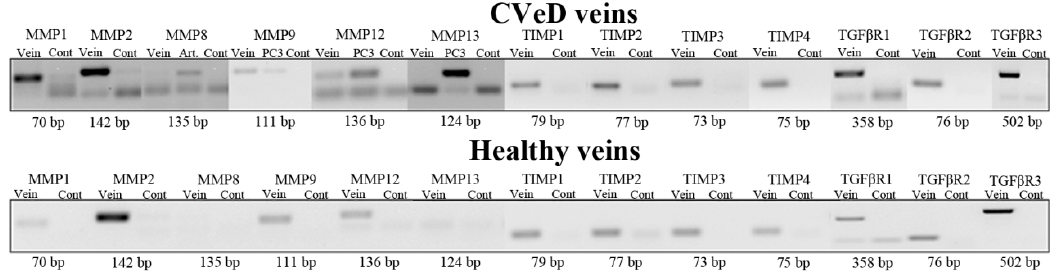
Figure 1. PCR analysis of several matrix metalloproteinases (MMPs), tissue inhibitors of metalloproteinases (TIMPs), and transforming growth factor- β receptors (TGF β Rs) in cDNA pools of varicose and healthy veins. Amplification of β -actin housekeeping gene was used as a control of the cDNA synthesis. Umbilical arteries or the PC3 prostate cell line was used as a positive control for the amplification of MMP8 , MMP9 , MMP12 , and MMP13 in varicose veins.